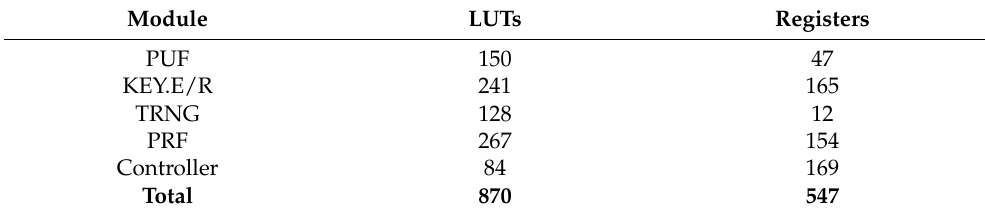
Table 1. The proposed protocol’s execution costs.